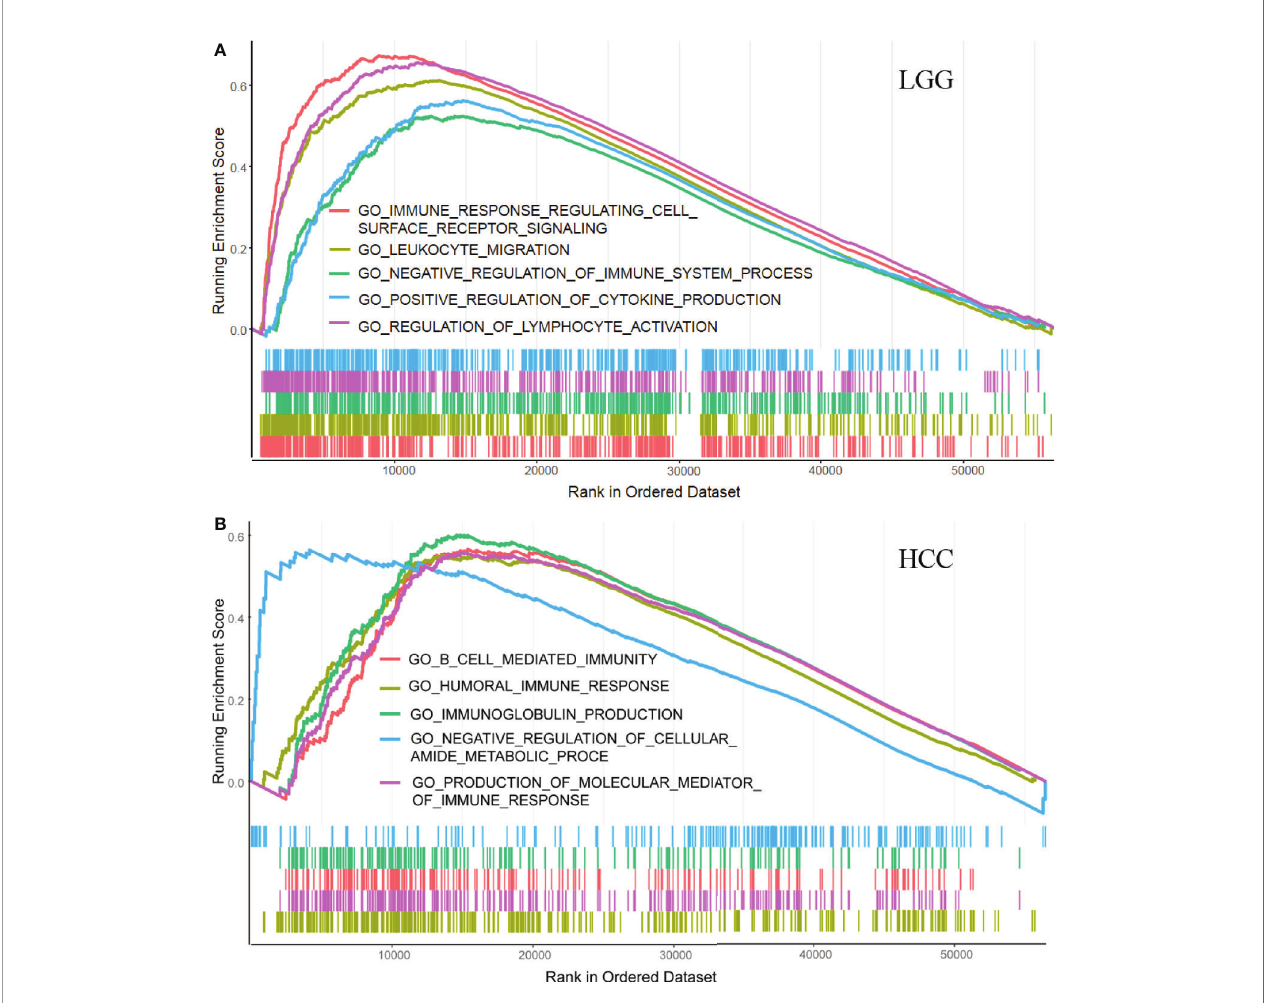
FIGURE 5 | GSEA results showing differential enrichment of genes in GO with high and low SLC1A5 expression in LGG (A) and HCC (B)